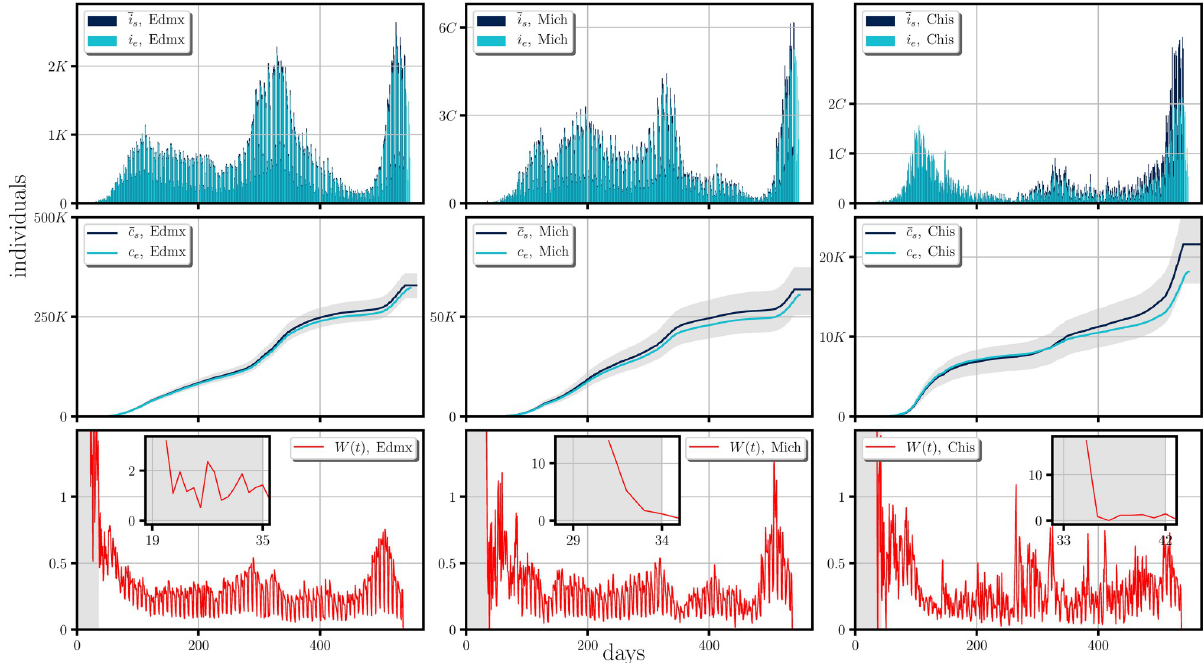
Fig 6. Comparison between the synthetic data generated by the stochastic model and real scenarios happening in some Mexican states and the form of their corresponding weight functions. The figure shows a comparison of the incidence (first row) and its cumulative (second row), between the synthetic data ( � i and � c ) generated by the stochastic model when averaged over 1000 trajectories to the real scenarios ( i s s Estado de Mexico(Edmx), Michoacan(Mich) and Chiapas(Chis). The shaded region for the cumulative of the incidence represents the 1st and the 3th quartil of the cumulative of the synthetic incidence generated randomly. The synthetic data was generated by employing the empirical estimation of the weight function (last row) obtained form Eq (16). The figure shows a period of roughly a year and a half of the spreading of the SARS-CoV-2